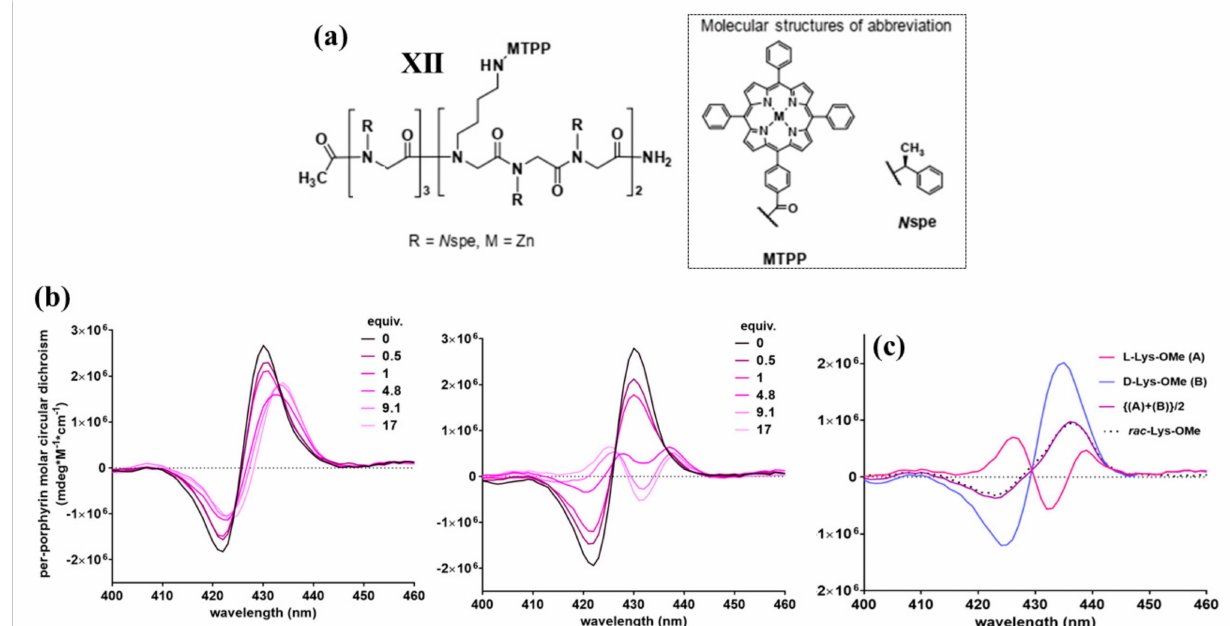
Figure 9. ( a ) Structure of the chiral metalloporphyrin tweezer bridged by a peptoid helix XII ; ( b ) Titration CD spectra of chiral tweezer XII with an increasing amount of D- (on the left) and L-lysine methyl ester (on the right) in dichloromethane; ( c ) CD spectra of chiral tweezer XII with 17 equivalences of L-lysine methyl ester, D-lysine methyl ester, or racemic mixture of lysine methyl ester. Adapted from reference [67] under Creative Commons CC BY 4.0 license; published by MDPI AG 2018.